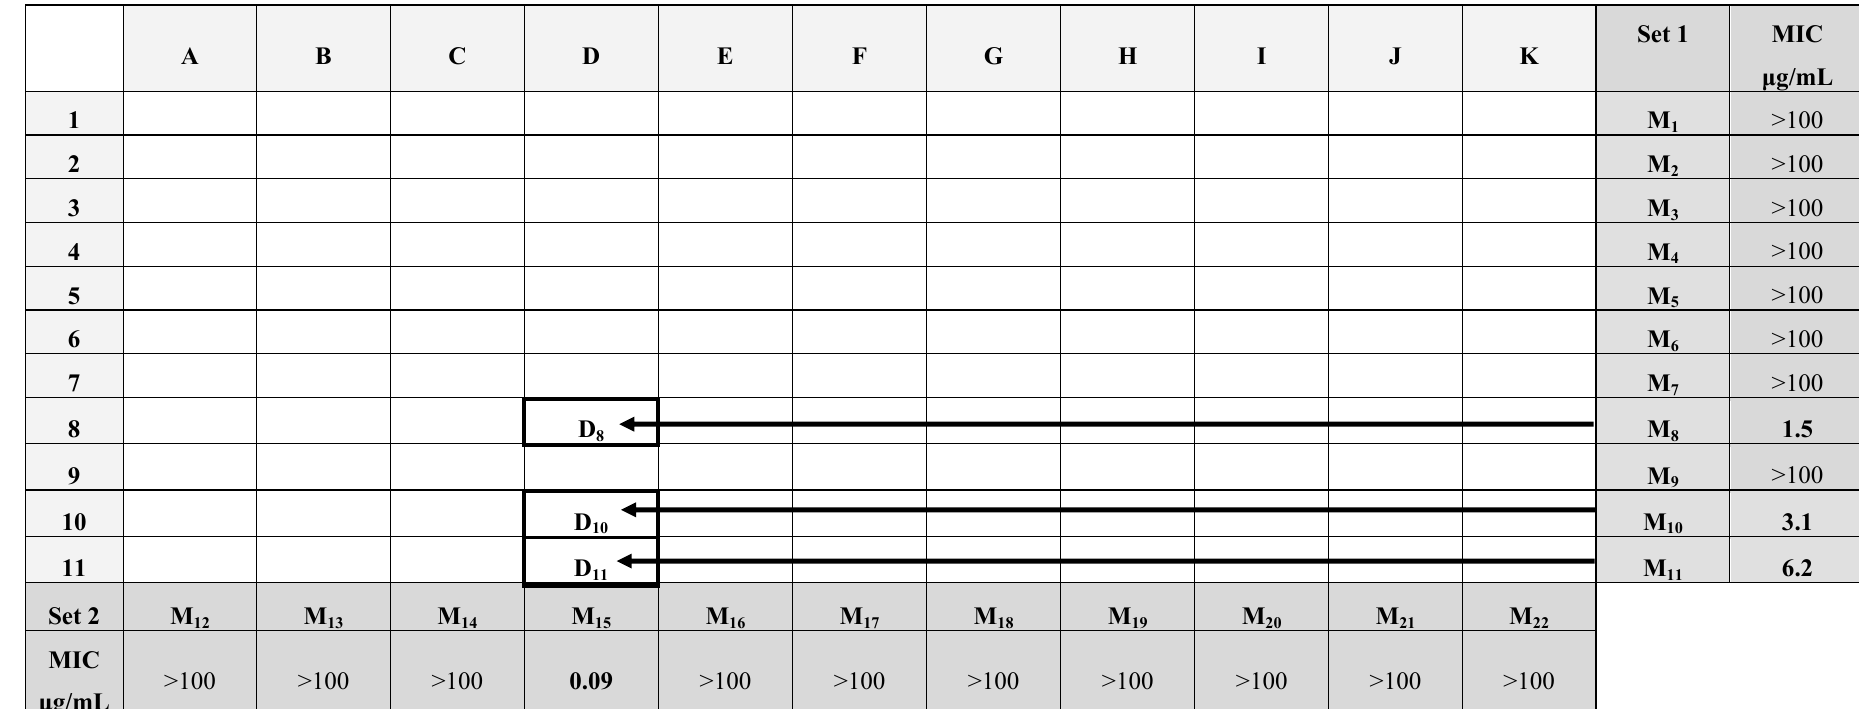
Table 2. Antimycobacterial evaluation results of the synthesized combinatorial mixtures M orthogonal deconvolution for prediction of the active